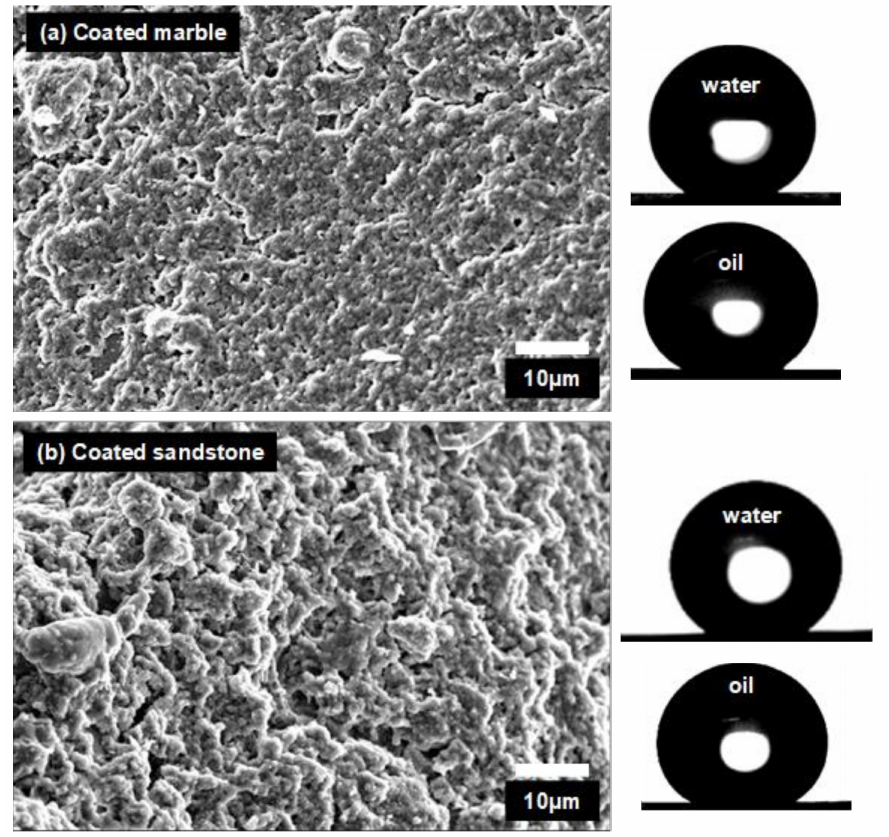
Figure 2. SEM images of ( a ) marble and ( b ) sandstone coated by Silres + nanoparticles films. Photographs of water and oil drops are included.